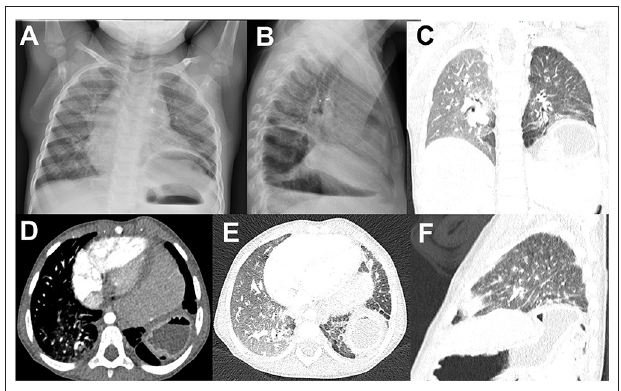
FIGURE 2 | Radiological image of the major recurrence of left side CDH after a first patched diaphragmatic closure. (A,B) Chest X-ray image, (C–F) computed tomography